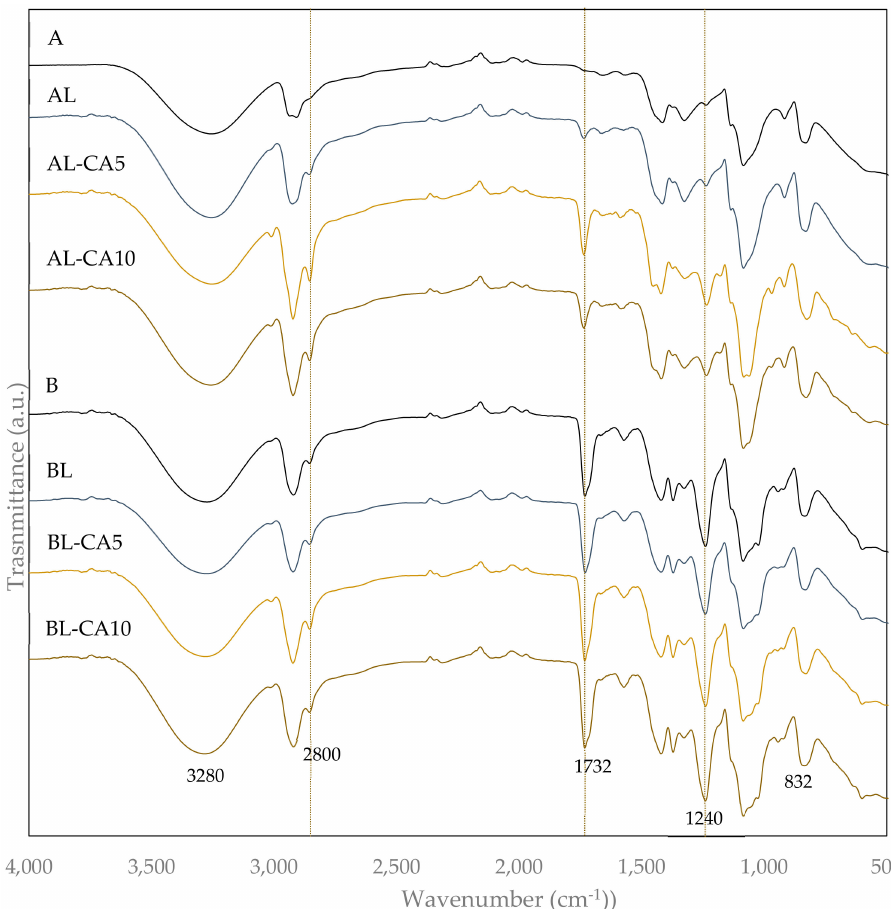
Figure 3. FTIR spectra of the PVA films (A and B) without and with carvacrol (5 or 10 g / 100 g PVA) previously encapsulated in lecithin liposomes